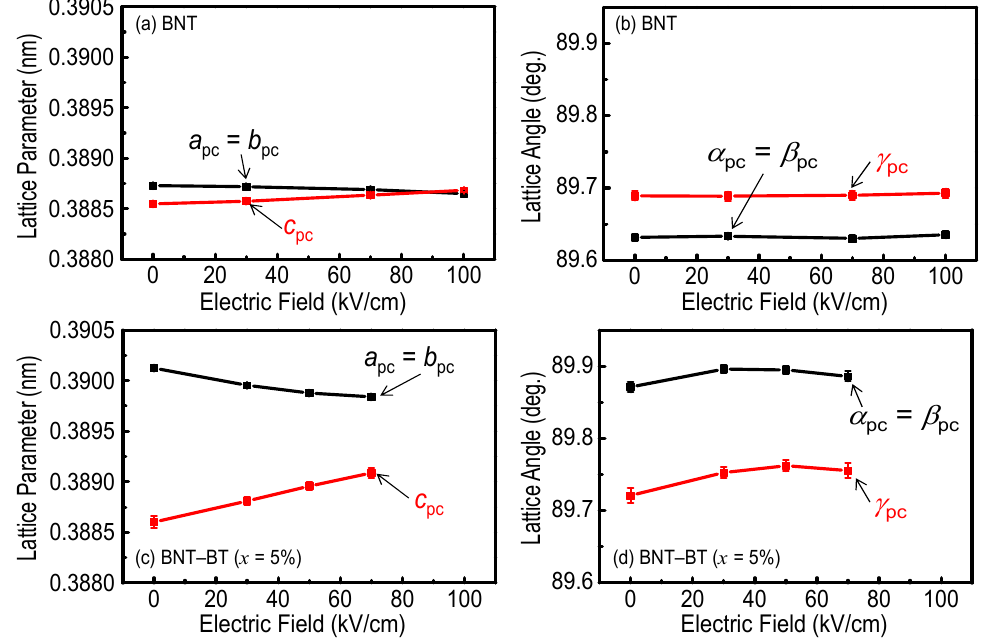
Figure 6. Pseudo-cubic (pc) unit-cell parameters as a function of E ( a ) lattice parameters and ( b ) lattice angel observed for the BNT crystals, ( c ) lattice parameters and ( d ) lattice angel observed for the BNT–5%BT